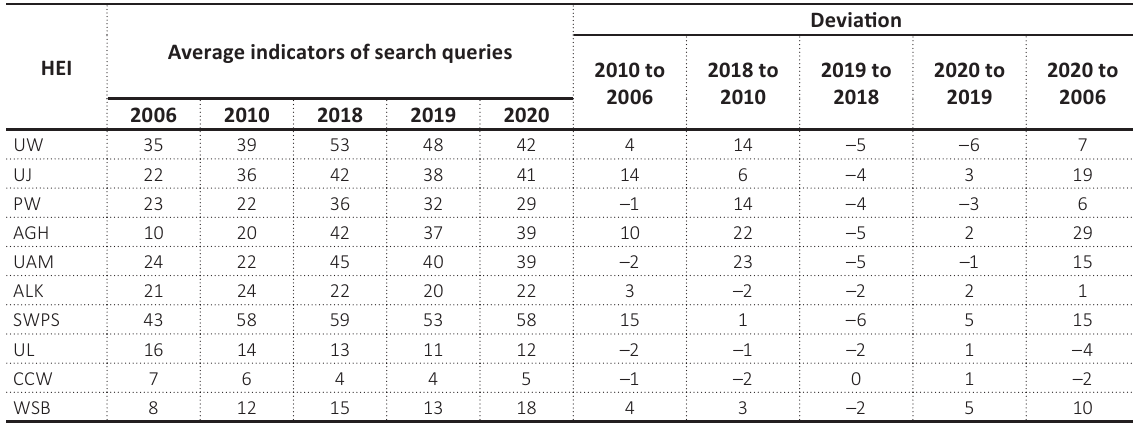
Table 3. Analysis of the relative number of official queries in Poland from 2006 to 2020 on Google platform, % of max